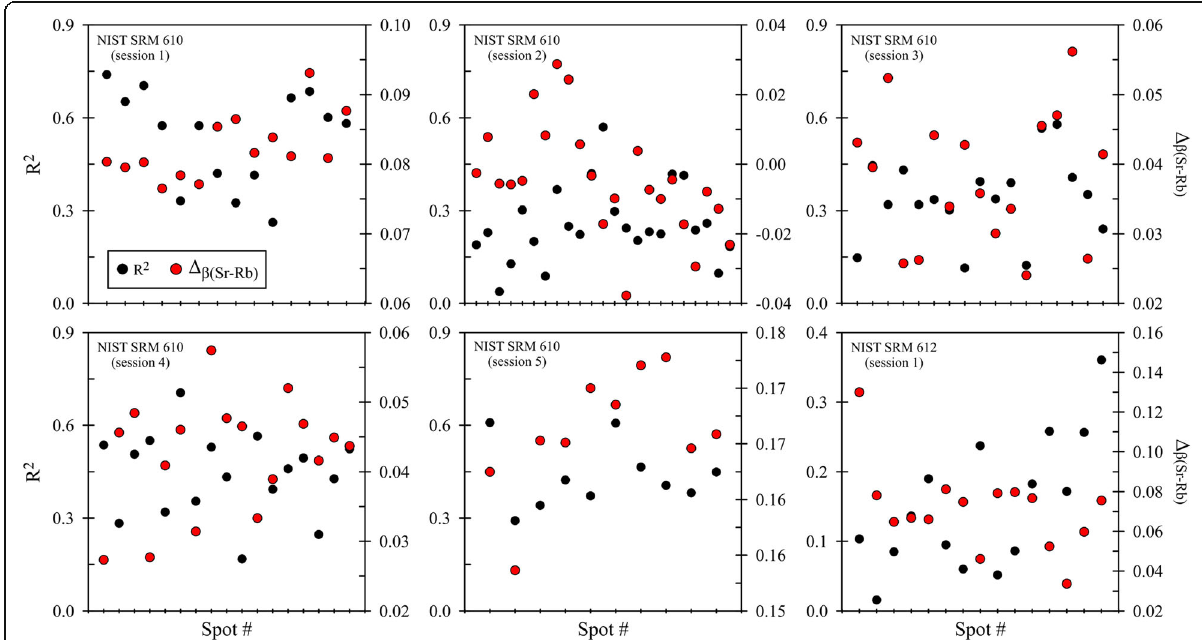
Fig. 5 R 2 values and differences between β (Sr) and β (Rb) [ Δ β (Sr − Rb) ] calculated from LA-MC-ICPMS data for NIST SRMs